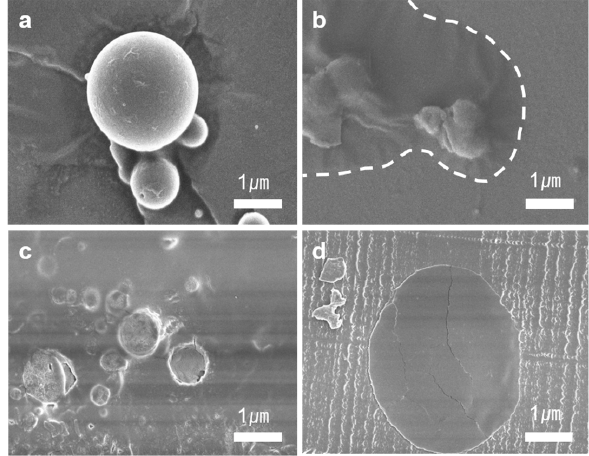
Figure 3. Cracking and crack-healing of s microcapsule. SEM images of ( a ) micro-sized core-shell-like TCE-co-DCE capsules; ( b ) TCE-co-DCE monomers spilled out of the cracked microcapsules on to the floor; ( c ) microcapsules embedded in an epoxy resin; and ( d ) a microtome sectioned area after cracking and irradiation of light.